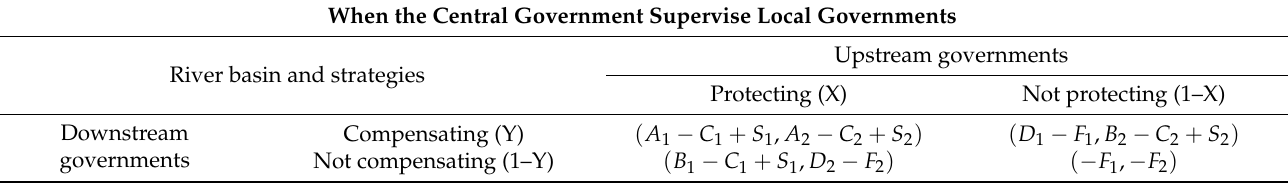
Table 4. Payoff matrix for both players with the supervision of the central